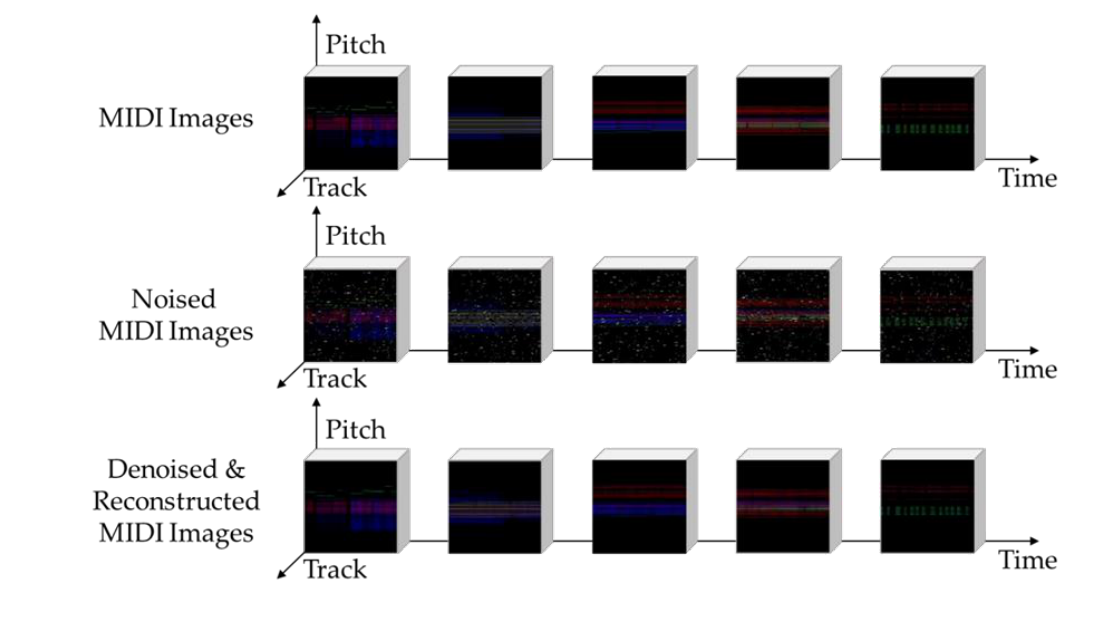
Figure 5. Experimental results of MIDI preprocessing.